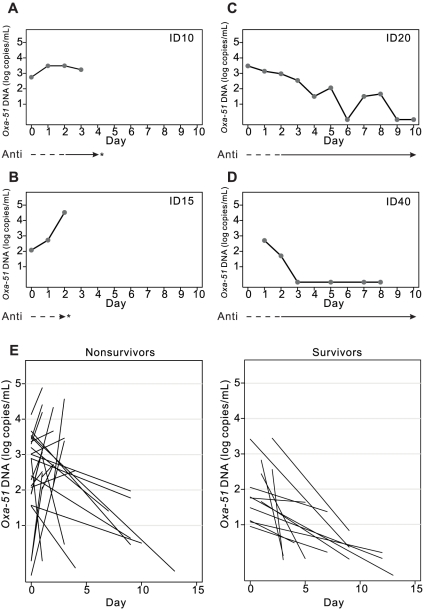
Sequential Oxa-51 DNA loads in blood during the course of A. baumannii bacteremia.Sequential whole blood samples from 2 nonsurvivors (A, B) and 2 survivors (C, D) with A. baumannii bacteremia were subjected to DNA extraction and the Oxa-51 real-time PCR assay. The lines beneath indicate inappropriate (—) and appropriate (—) antibiotic therapy, and the asters indicate death. (E) Overall change of Oxa-51 DNA load in blood for patients with A. baumannii bacteremia (27 nonsurvivors, 13 survivors) assessed by the slope of the linear regression of log Oxa-51 DNA copies per mL plotted against time.